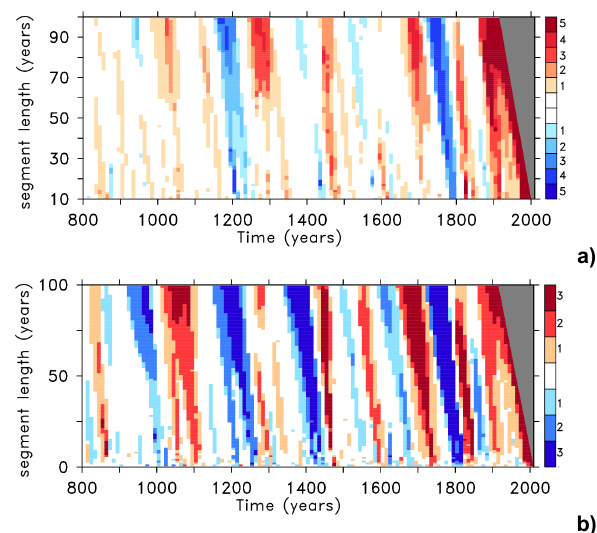
Fig. 5. Analysis of trends in the full-forcing experiments in the en- sembles E1 (a) and E2 (b) . The analysis identifies periods during which warming (shades of red) and cooling (shades of blue) trends (starting dates at the x-axis) exceed the 5th–95th percentile range of the respective trends in the control experiment. The intensity of the colour denotes the number of ensemble members showing the same behaviour so that, for example, the darkest shade of red indi- cates that all ensemble members show warming trends significantly different from the control